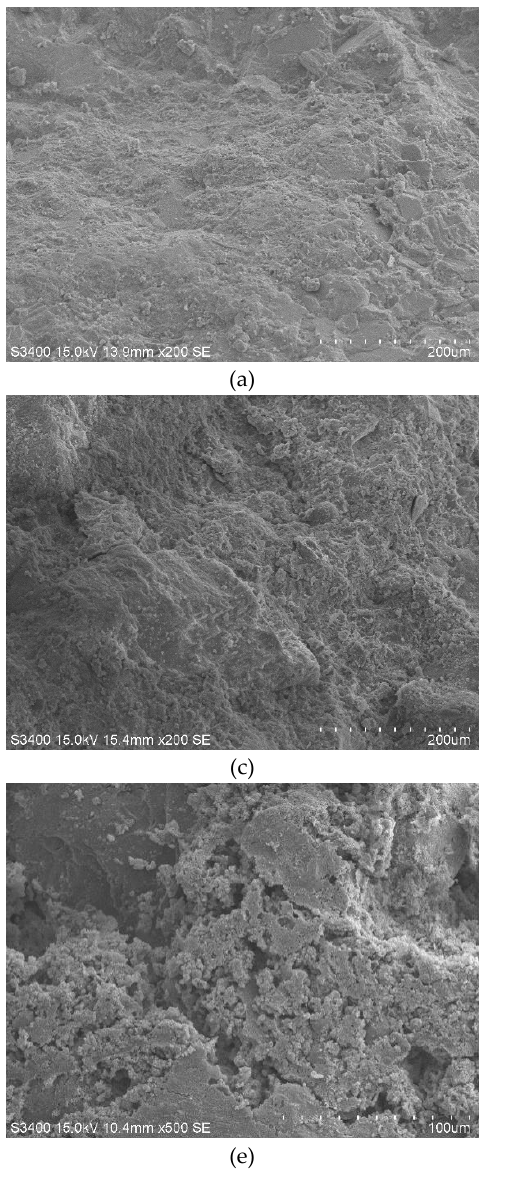
Figure 10. Micro-structures of cement matrix of NC after exposure to different temperature: ( a ) 20 ° C, ( b ) 200 ° C, ( c ) 400 ° C, ( d ) 600 ° C, ( e ) 800 ° C, ( f ) 1000 ° C .